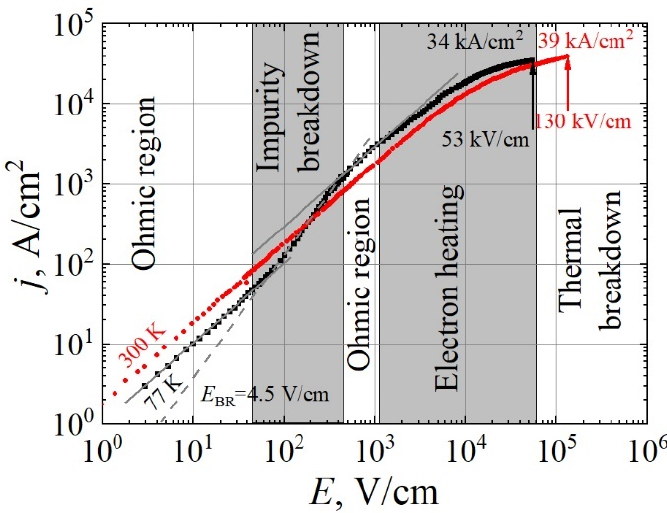
Figure 7. Pulsed current density versus electric field characteristics of n -type GaN epilayer at T = 77 K (Resistor R 1 with the length and width of 55 µ m and 500 µ m, respectively; black squares) and 300 K (Resistor R 2 with the length and width of 45 µ m and 500 µ m, respectively; red circles). At 77 K, distinct features attributed to impurity ionization and carrier heating were observed in the region of ~38–450 V/cm and fields higher than ~1200 V/cm, respectively. Breakdown of the resistor occurred at the electric field of about 53 kV/cm. At 300 K, the I/V curve is linear up to electric fields of ~1.5 kV/cm, followed by electron heating and eventual breakdown at the electric field of 130 kV/cm. Maximum injected electric power till the damage of GaN epilayer was found to be up to 1.8 × 10 9 W/cm 3 and 5.1 × 10 9 W/cm 3 at 77 K and 300 K, respectively.